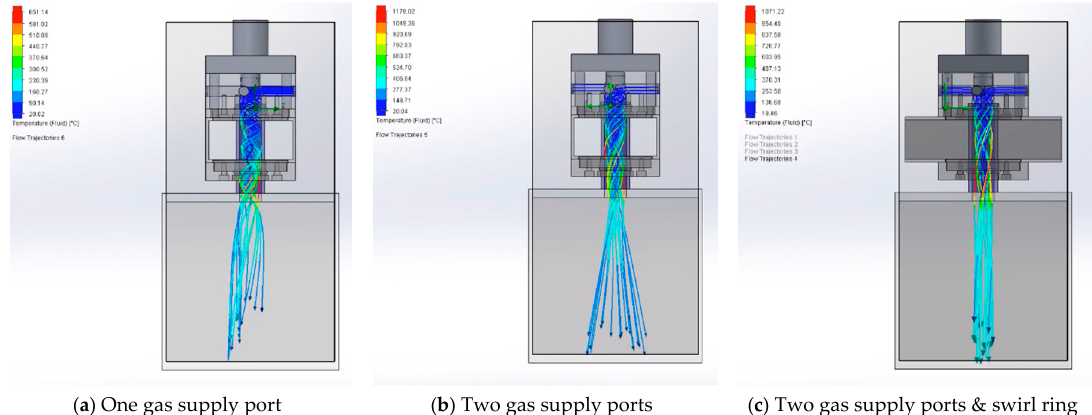
Figure 7 . CFD simulation of the gas flow dynamics .